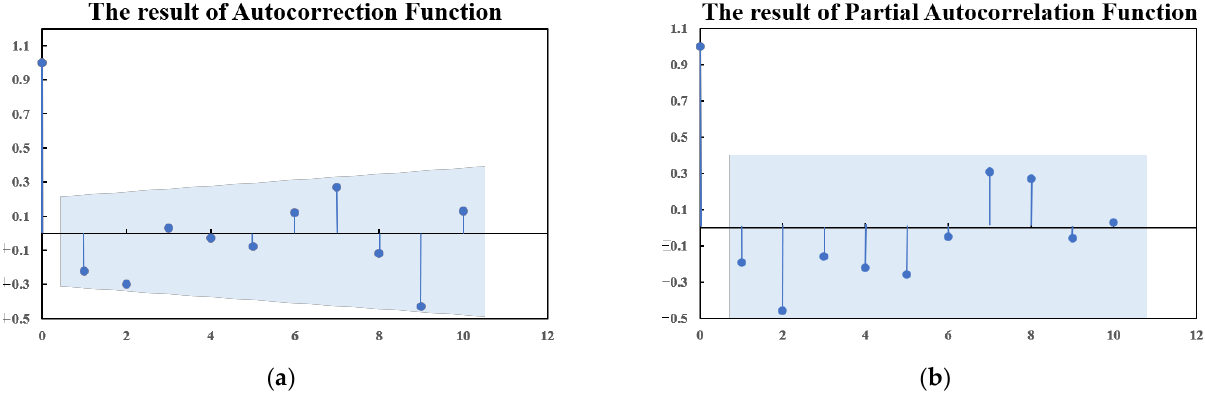
Figure 6. The results of ACF ( a ) and PACF ( b ).